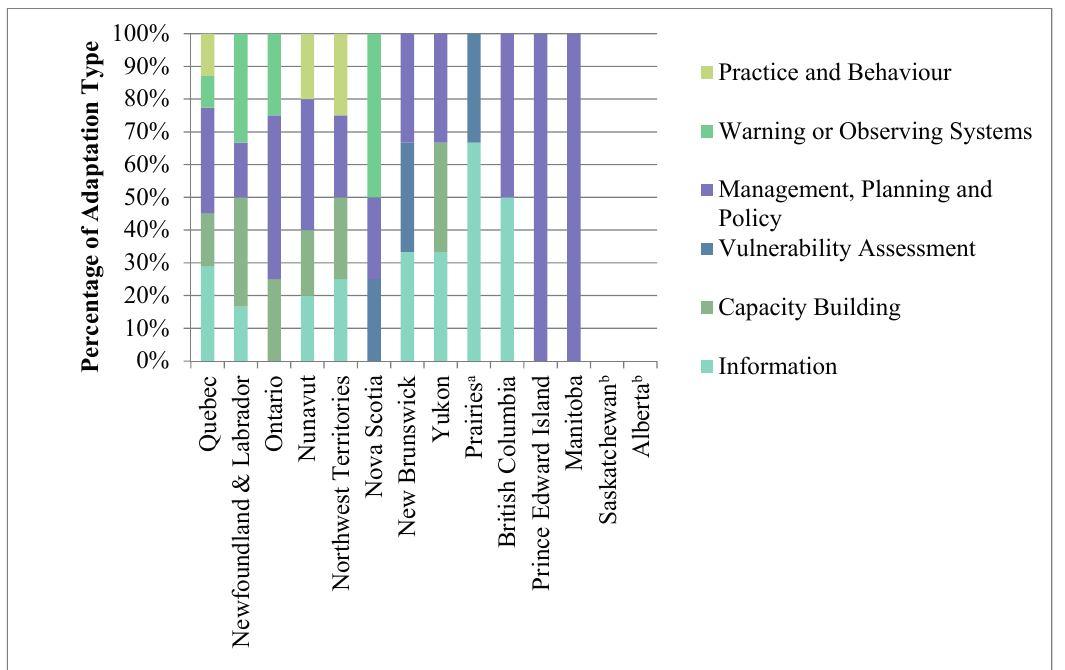
Figure 5. Percentage of health adaptation types by province or territory. Adapted from Biagini et al. [64] . a The three Prairie provinces (Alberta, Saskatchewan and Manitoba) have implemented three joint regional initiatives.; b Saskatchewan and Alberta do not report implementing any health adaptation initiatives other than the three joint Prairie provinces